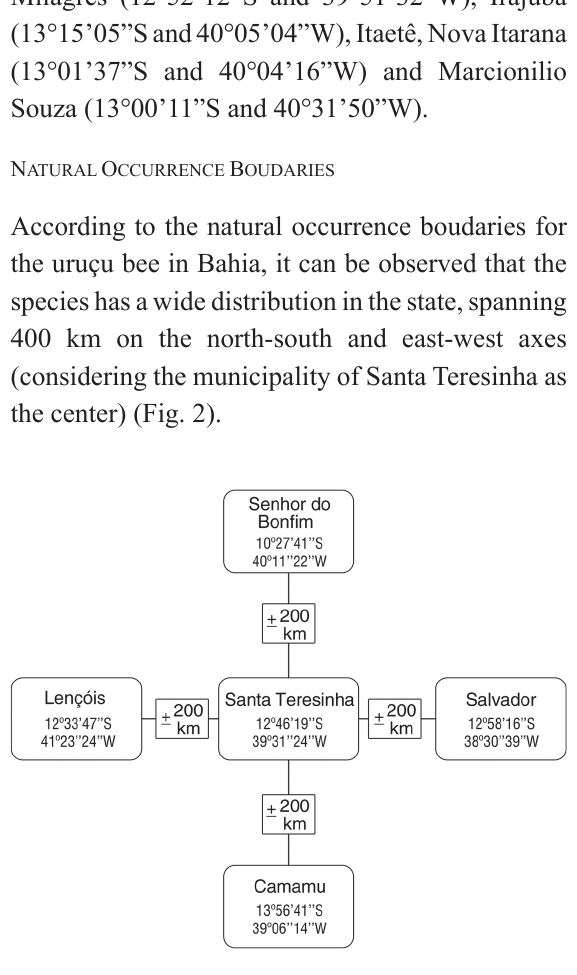
Fig. 2 - Occurrence boundaries for the species Melipona scutellaris